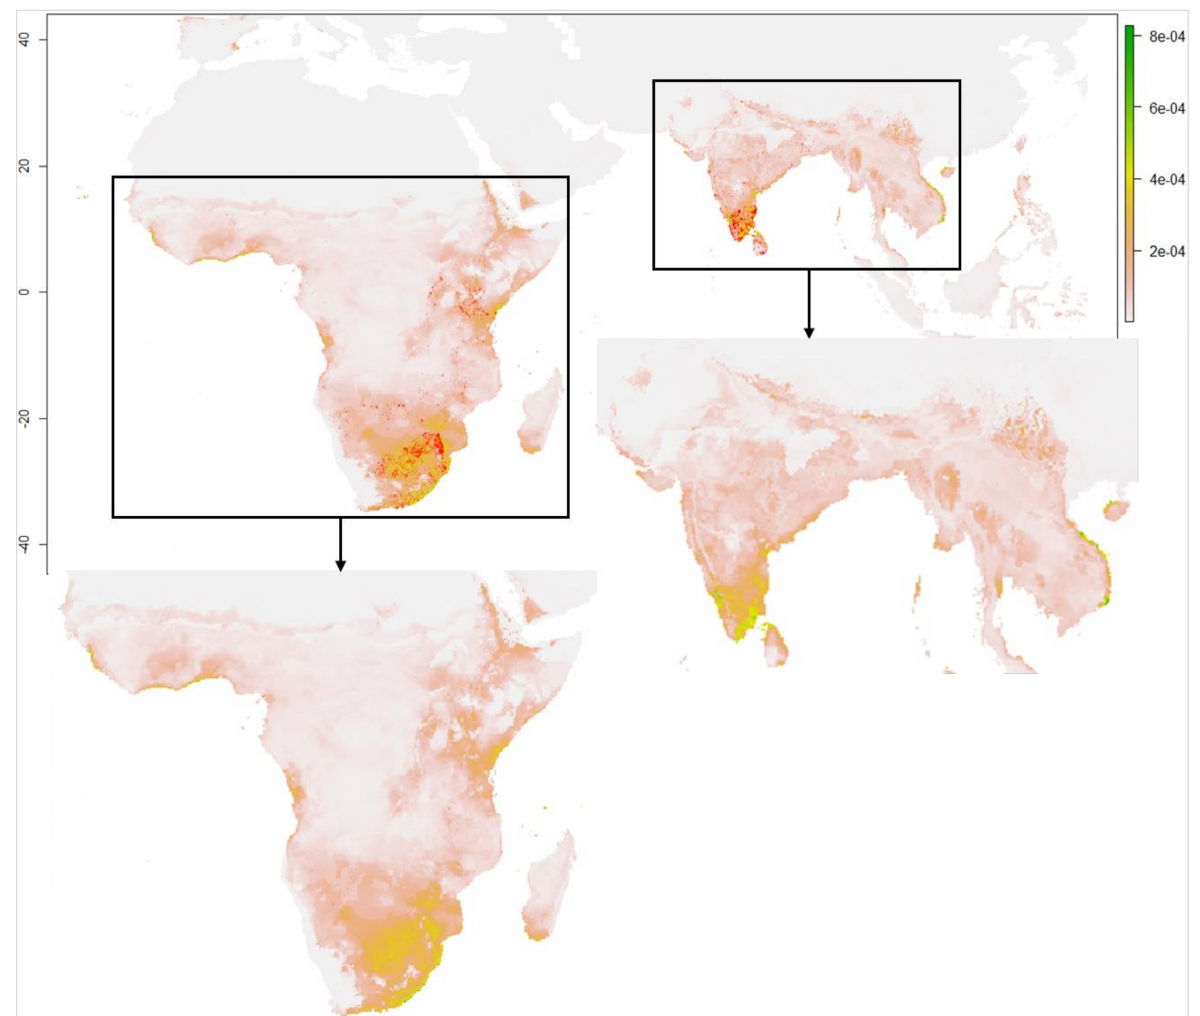
Figure 8. Current habitat suitability prediction of January-May for the Pied cuckoo